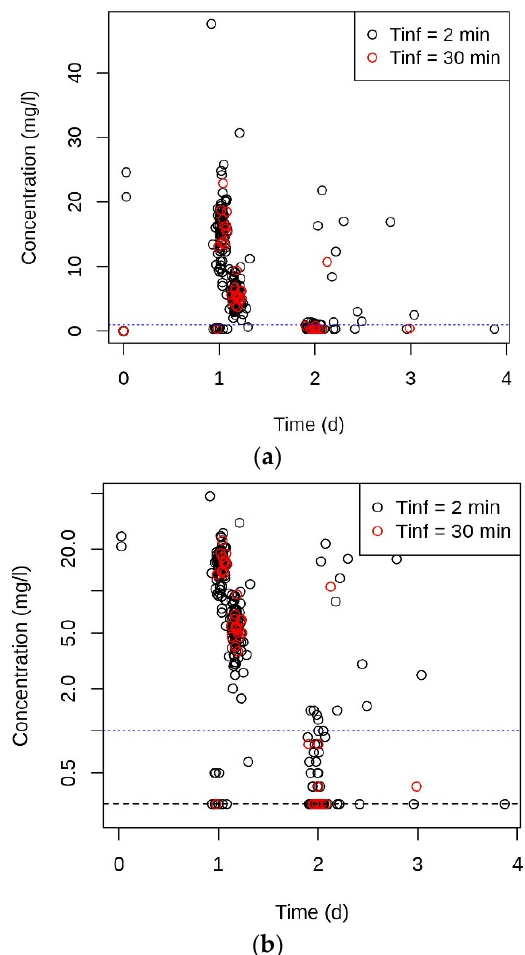
Figure 2. All measured gentamicin plasma concentrations of the 109 patients plotted against time after the start of the first of 2 or 3 infusions. ( a ) Linear, ( b ) logarithmic concentration scale. Most concentrations were determined during the 2nd dosing interval. Black and red symbols, concentrations after 2 and 30 min infusion, respectively. Blue dotted lines, recommended maximal trough concentration (1 mg/L). Horizontal broken black line in ( b ), LOQ (0.3 mg/L). All data were included for the modeling (up to 3 infusions). Concentrations < LOQ are indicated at LOQ in the Figure.